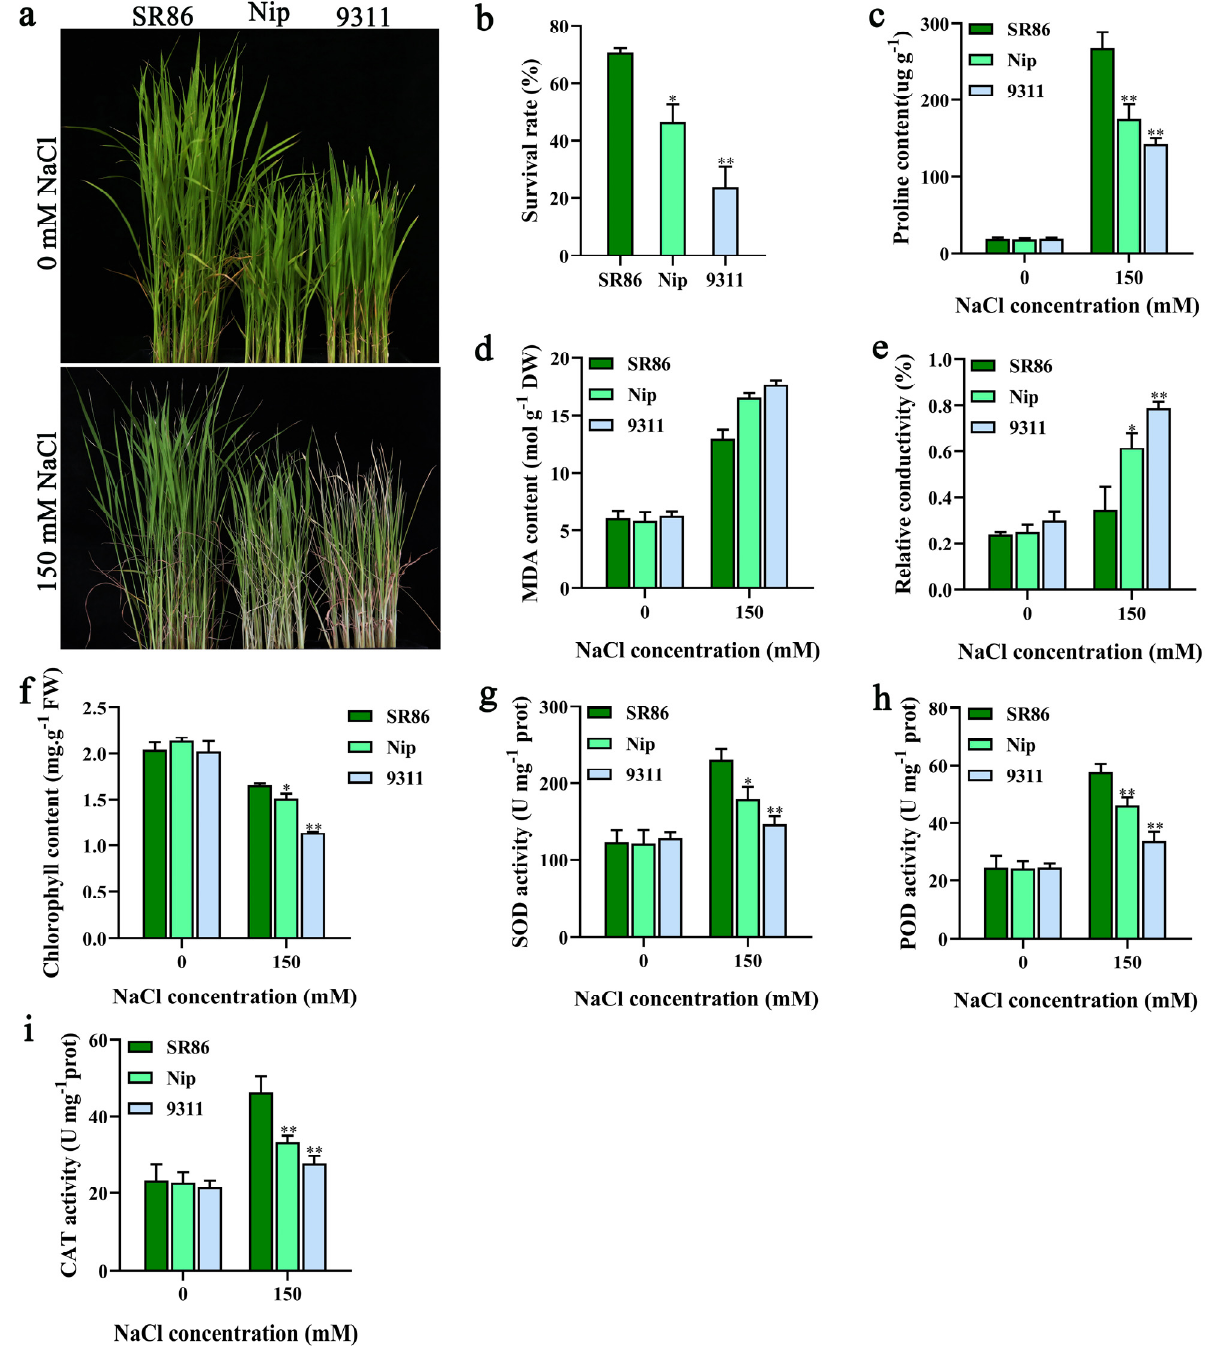
Figure 1. The phenotypic comparison of SR86, Nip, and 9311 plants under salt stress conditions. ( a − i ) Phenotype ( a ), survival rate ( b ), proline content ( c ), MDA content ( d ), relative electrical conductivity ( e ), chlorophyll content ( f ), SOD activity ( g ), POD activity ( h ), and CAT activity ( i ) of SR86, Nip, and 9311 plants after treatment with 150 mM NaCl solution for 5 d. The data represent the mean ± SD of three independent replicates. Asterisks indicate statistically significant differences (* p < 0.05, ** p < 0.01).